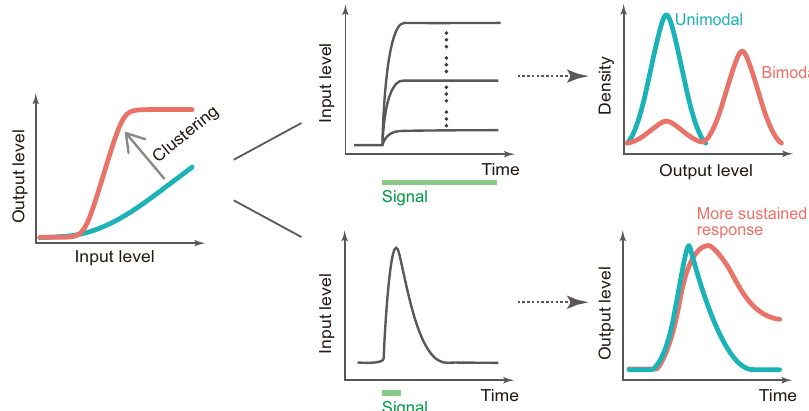
Fig. 6 A summary of the modulation of the gene regulation function by TF clustering and the resulting behaviors of the system. TF clustering modulates the gene regulation function by tuning both the effective binding af fi nity and the ultrasensitivity (i.e., Hill coef fi cient) (left), leading to bimodal target response (output) at steady state (top right). When subjected to a transient signal, TF clustering confers a sustained transcriptional response of the target gene, whereby the output signal decays much slower compared to the scenario without TF clustering (bottom right). Note that the effective binding af fi nity is modulated by a larger extent compared to the